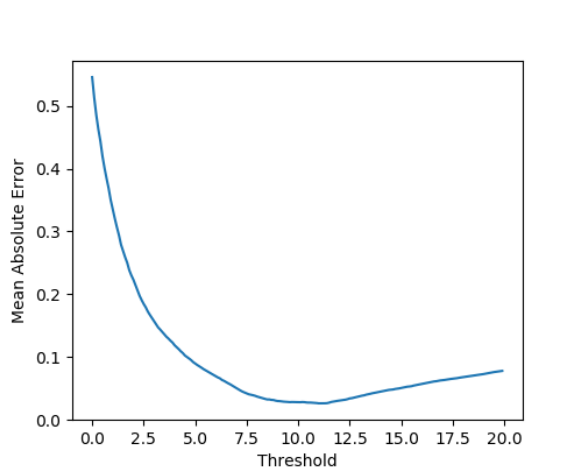
Figure 5. Mean Absolute Error depending on the threshold chosen for C/DiffMedSigmaT